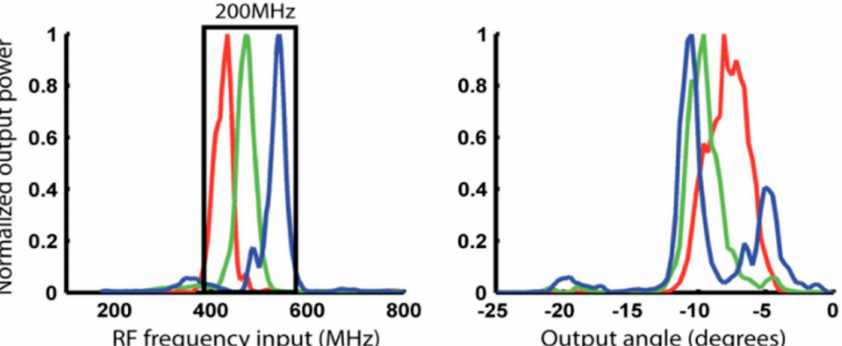
Figure 4. Frequency ( left ) and output angle ( right ) for an RGB leaky mode modulator with mode coupling transitions chosen to abut in frequency and to overlap in angle (the corresponding setup is shown in Figure 9a). Reprinted with permission from [16] © The Optical